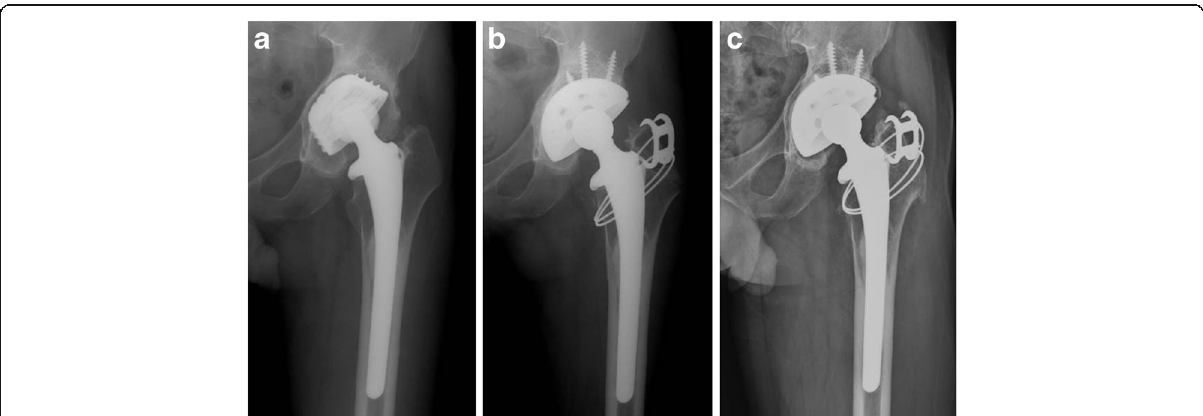
Fig. 1 ( a ) Preoperative radiograph showing aseptic loosening of acetabular cup; ( b ) Postoperative radiograph of cementless total hip arthroplasty performed with Longevity higly cross-linked polyethylene liner and 28-mm metal head; ( c ) Twelve-year follow-up radiograph showing well-fixed prostheses without osteolysis. The polyethylene liner wear rate was